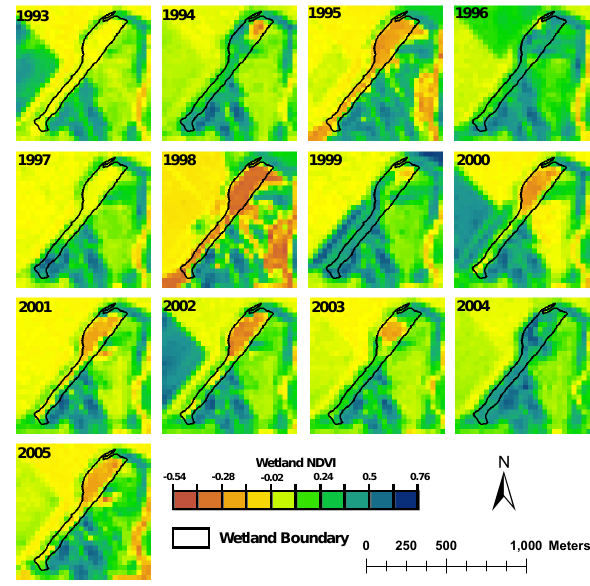
Fig. 2. Multi-temporal images (1993–2005; acquired during the month of July) of wetland NDVI, derived from Landsat TM im- agery. Low values (i.e., − 0.5; red) indicate open water, while high values (i.e., 0.75; blue) indicate dense vegetation. The wetland was